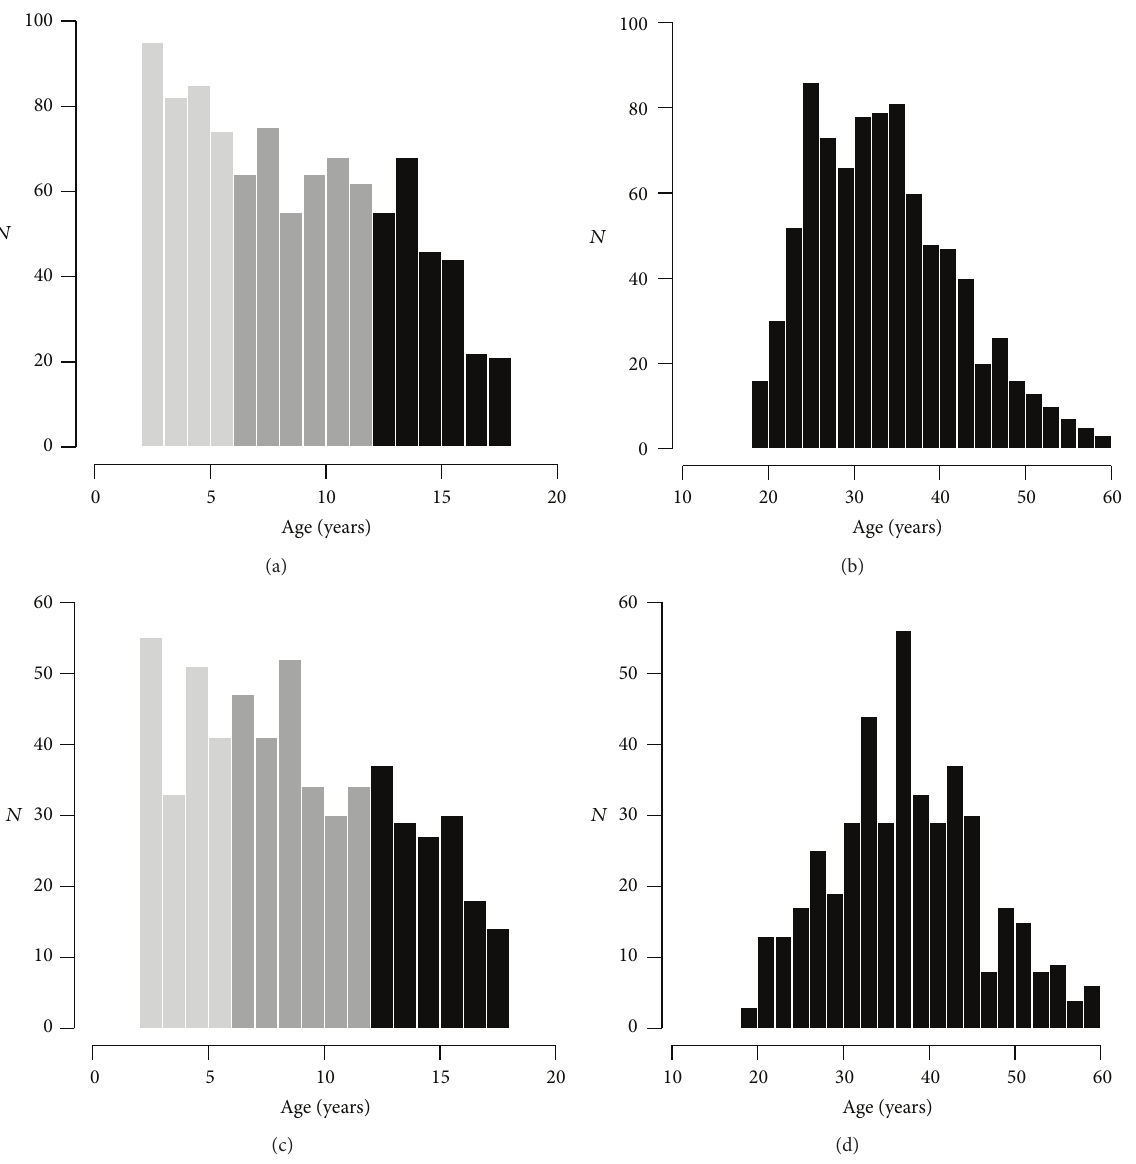
Figure 1: Histograms showing age distributions of the COHRA1 sample. (a) WV children, (b) WV adults, (c) PA children, and (d) PA adults. Light gray, dark gray, and black bars represent, respectively, the participants for whom primary, mixed, and permanent dentition was considered in this study. Age distributions were similar between WV and PA children, whereas WV adults were significantly younger than PA